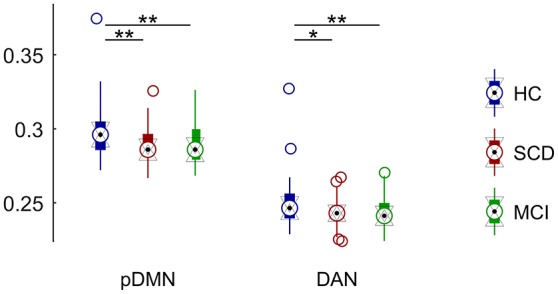
Distribution of mean connectivity values for each significantly different resting state network for HC (blue), SCD (red), and MCI (green). Asterisks mark significantly different connectivity values between groups. One asterisk (*) marks a p-value between 0.05 and 0.01. Two asterisks (**) mark a p-value lower than 0.01.